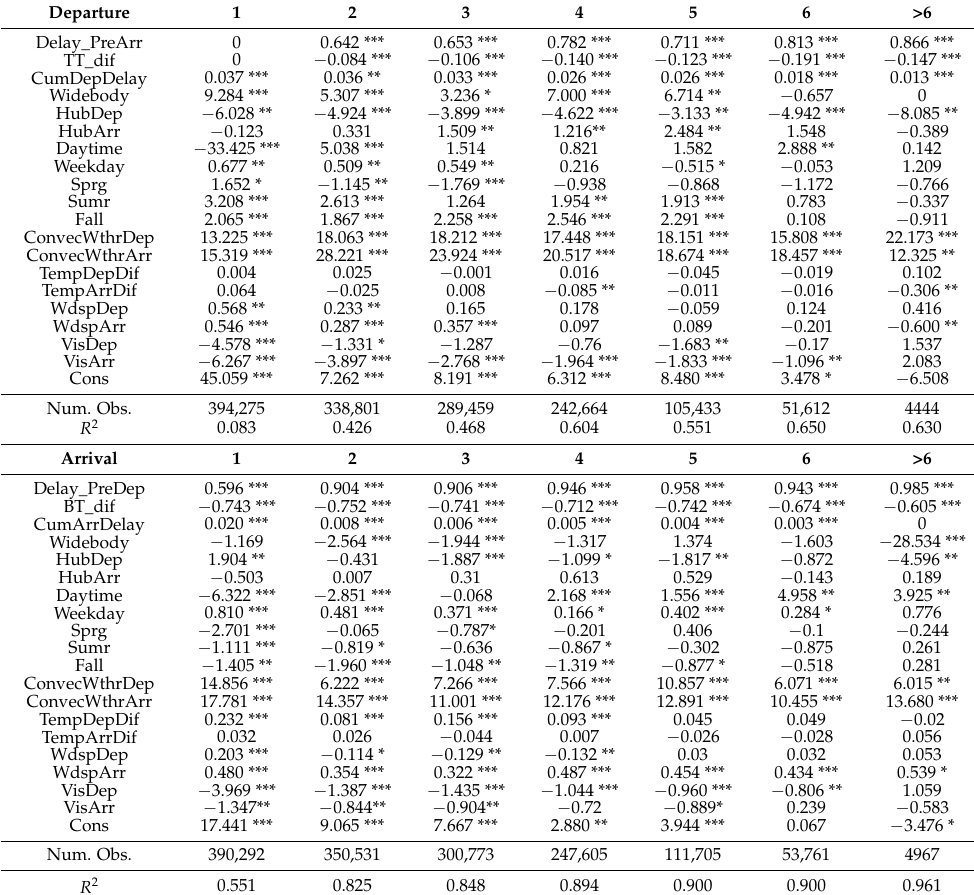
Table 4. Estimation results of flight delays for departure and arrival in different OrdFltOfAC.